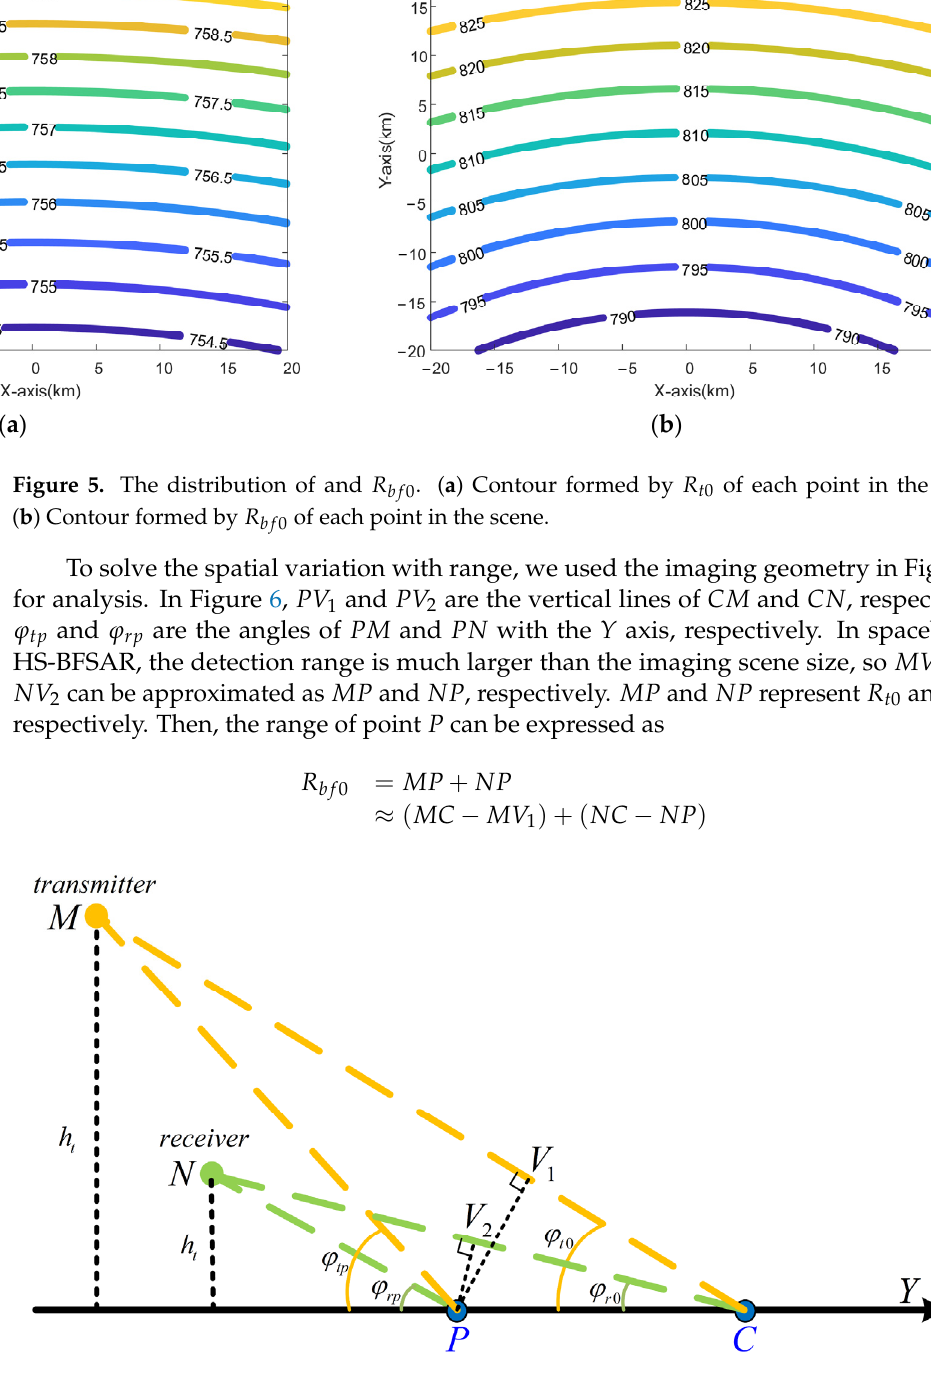
Figure 6. Imaging geometry at the synthetic aperture center time.